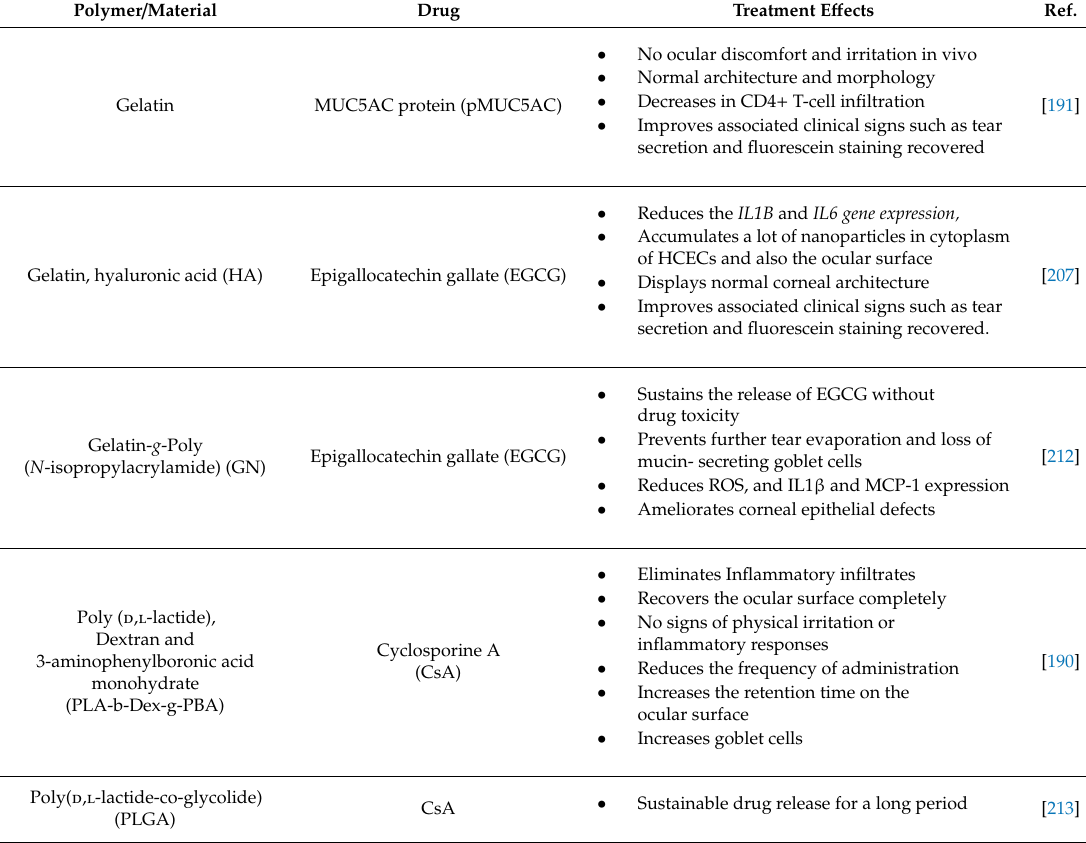
Table 2. New trend for nanomedicine in DED